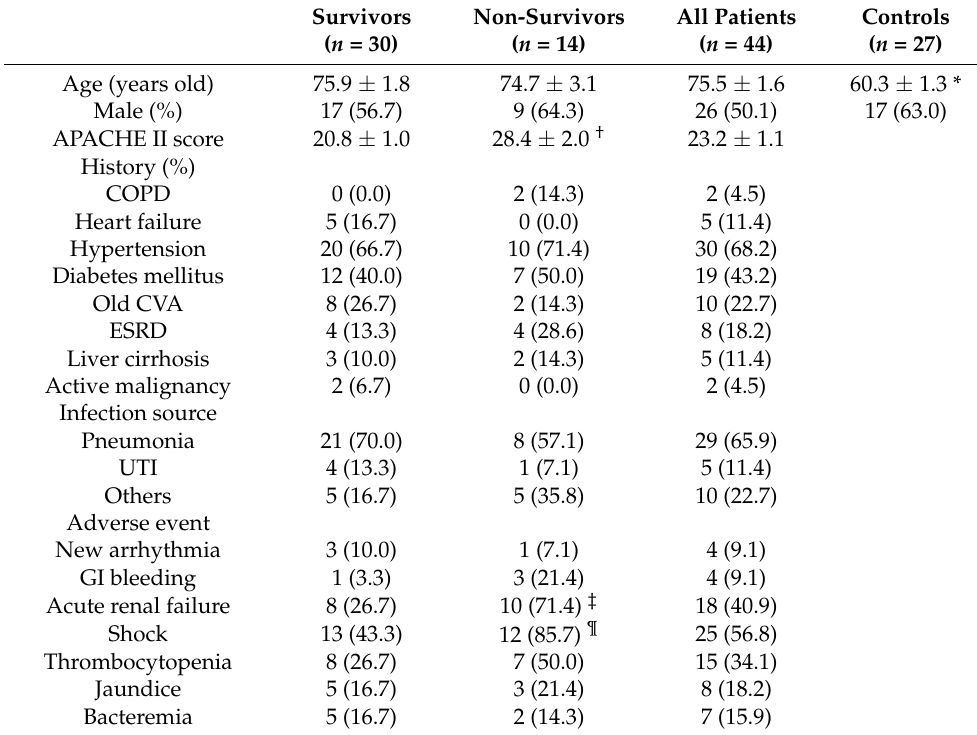
Table 1. Clinical characteristics in survivors, non-survivors, and controls (number, mean ± standard error